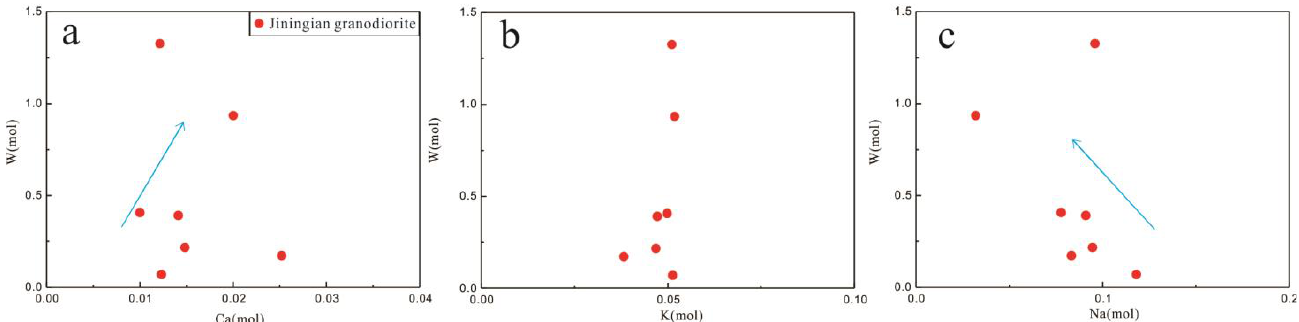
Figure 11. Ca-W, K-W and Na-W correlation diagram. The molarity of Ca, K and Na is obtained by dividing the major and trace elements (CaO, K 2 O, Na 2 O and W) by their respective relative molecular or atomic masses. ( a ) Ca vs. W, ( b ) K vs. W and ( c ) Na vs. W. The blue arrow indicates the trend of correlation.